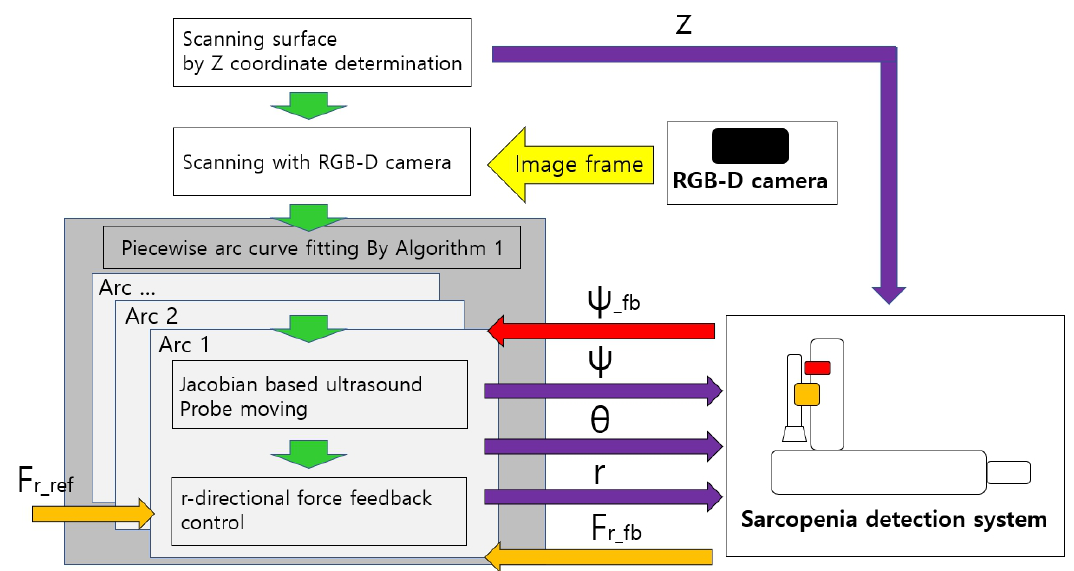
Figure 11. Overall control flow diagram of sarcopenia detection system—angular (planar) thigh